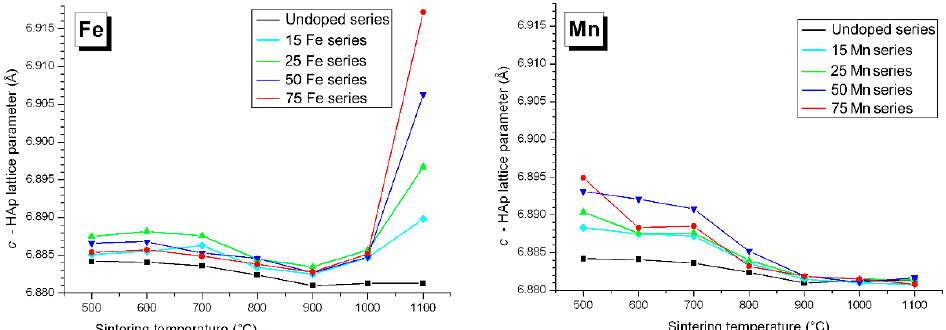
Figure 9. Variation in the hexagonal c axis of the HAp phase from all Zn-, Cu-, Ni-, Co-, Fe-, and Mn-doped samples: black lines for the undoped series, light blue lines for the 15 M -T series, green lines for the 25 M -T series, dark blue lines for the 50 M -T series, and red lines for the 75 M -T series. The lines are only visual guides.